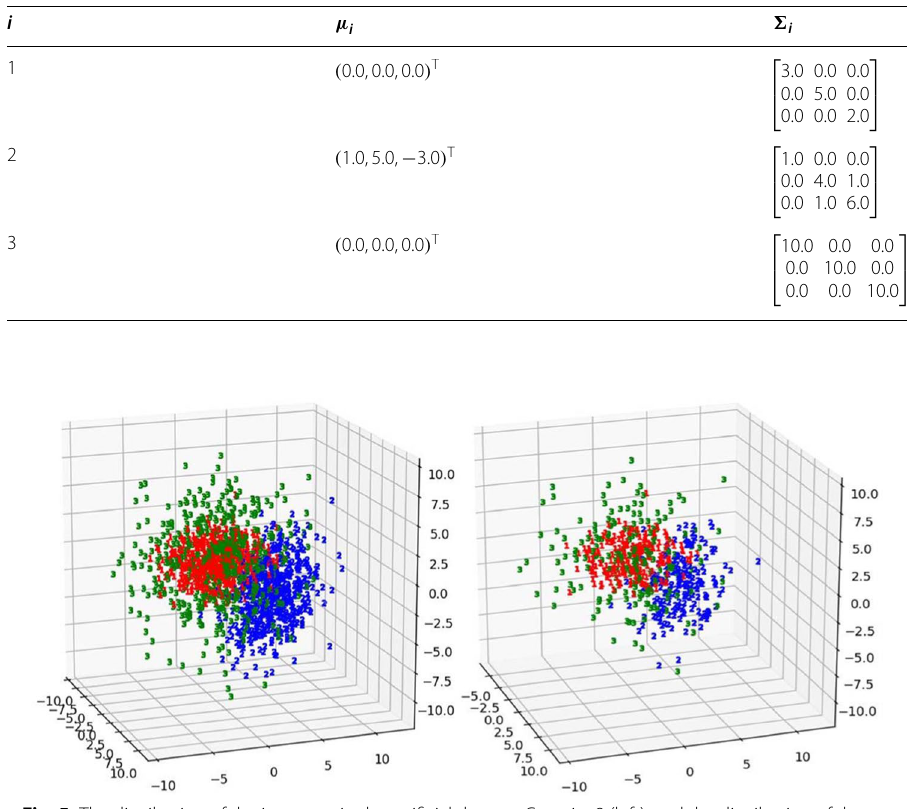
Fig. 5 The distribution of the instances in the artificial data set Gaussian2 (left), and the distribution of the instances selected from the artificial data set Gaussian2